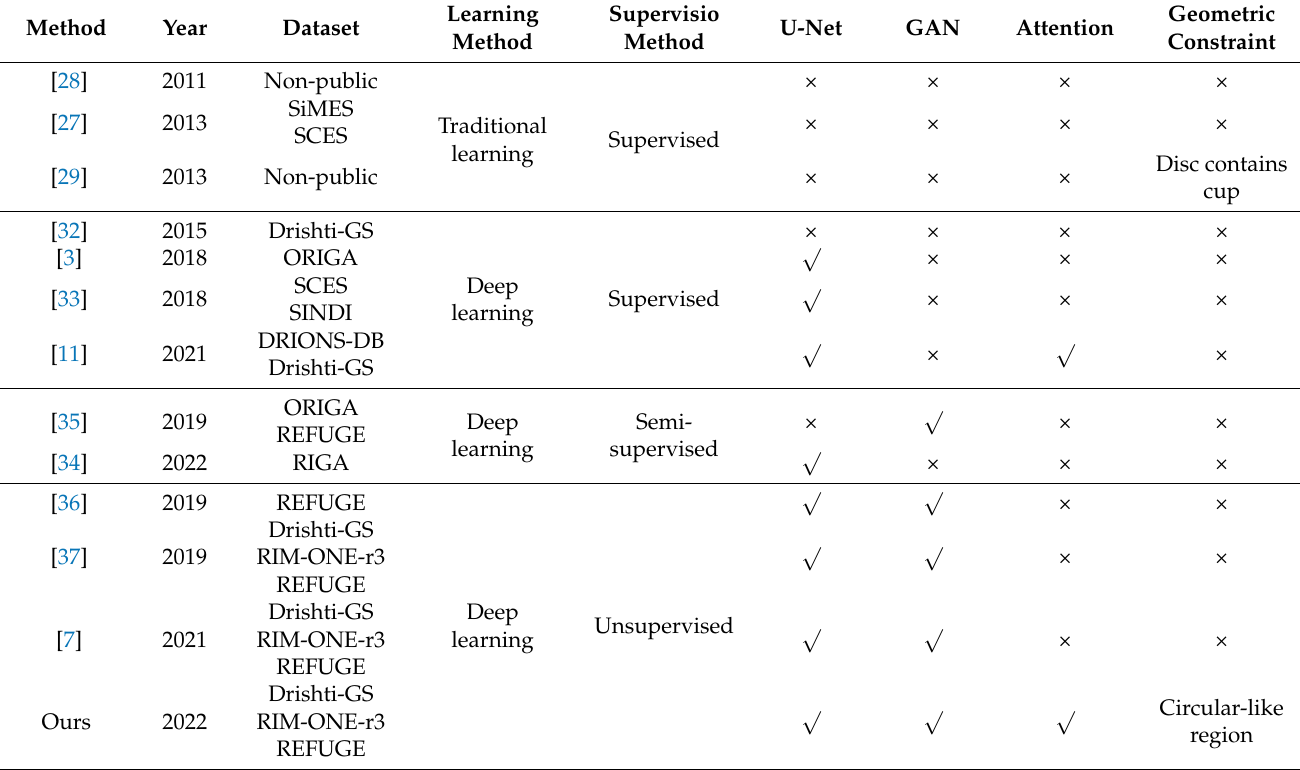
Table 1. Comparison of advantages and disadvantages of our method (SCUDA) with previous